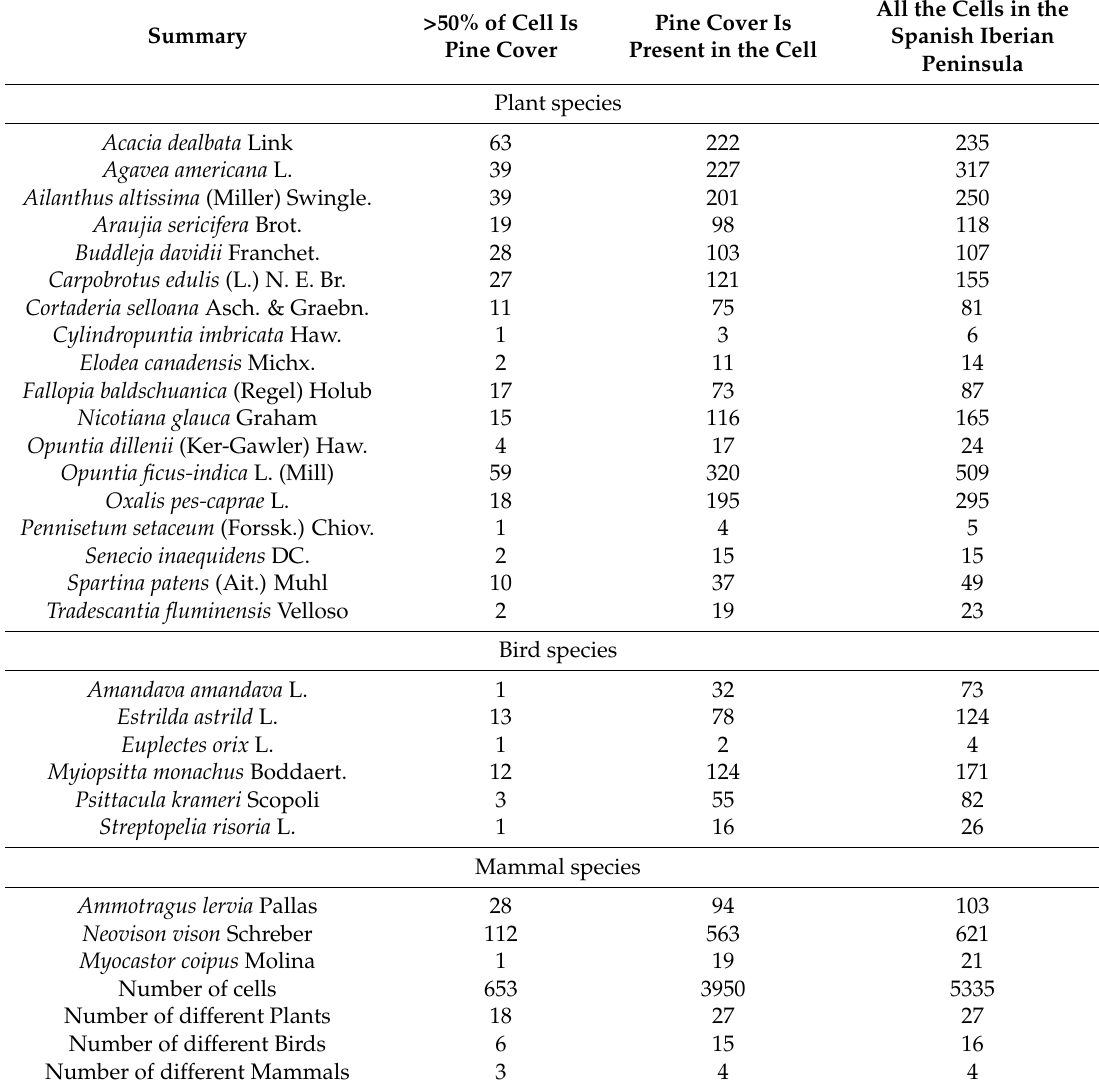
Table 1. List of invasive alien species used in this study. Presence of the species in the study area is given (cell = 10 × 10-km). Those species present in cells where PINE COVER exceeds 50% were selected. All the Cells in the >50% of Cell Is Pine Cover Is Spanish Iberian Summary Pine Cover Present in the Cell Peninsula Plant